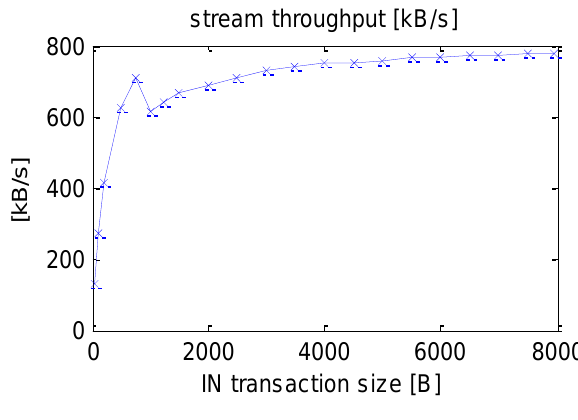
Figure 10. Average sensors datastream, in KB/s, depending on the size of packet